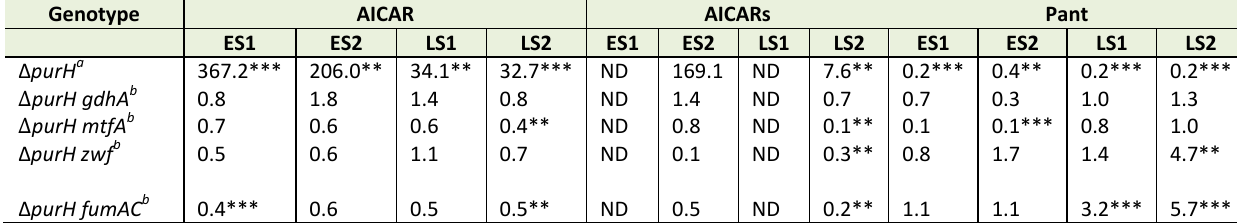
TABLE 3. Changes in central carbon metabolism reverse consequences of purH deletion. Genotype